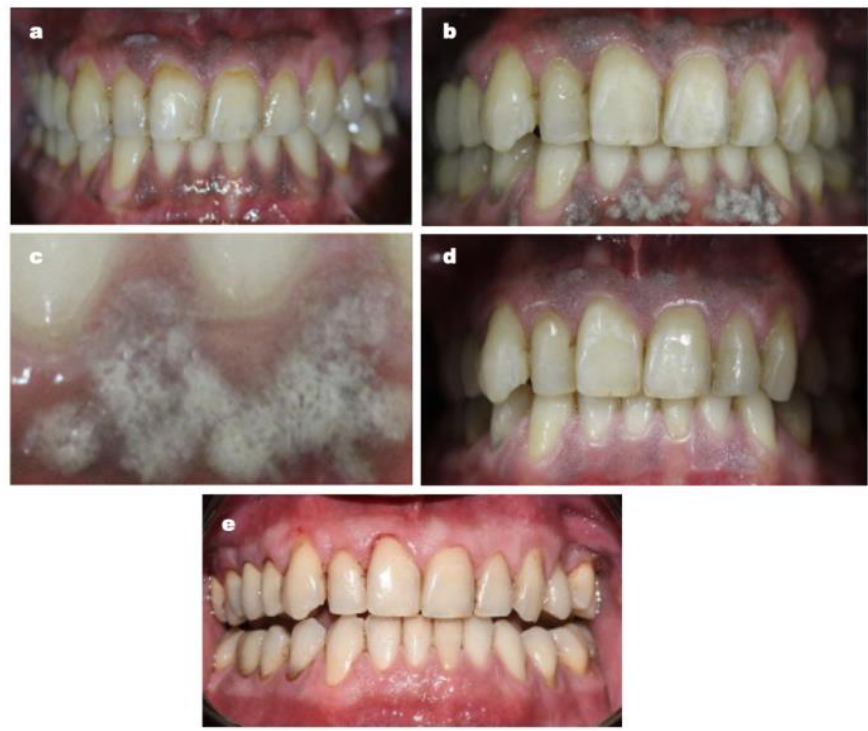
Figure 1. Patient no. 3: Preoperative optical findings ( a ); optical findings just after the laser application ( b ); frosting at higher magnification ( c ); optical findings immediately before the third laser application ( d ); 2 years after the treatment ( e ).